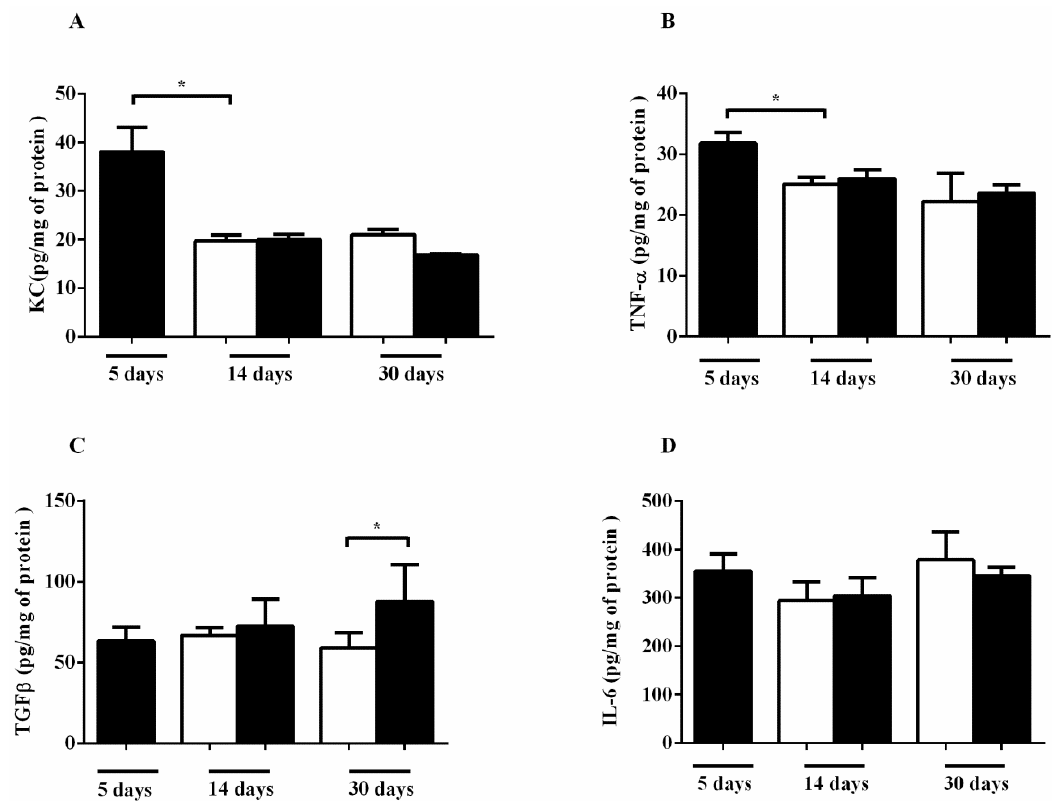
Figure 4. Effects of CS on cytokine production in the lung. The mice were exposed to 5, 14 and 30 days of CS (black bars) or ambient air (white bars) for 14 and 30 days and lung homogenates were isolated. The cytokines were measured by ELISA for ( A ) keratinocyte chemoattractant (KC), ( B ) interleukin-6 (IL-6), ( C ) tumor necrosis factor- α (TNF- α ) and ( D ) transforming growth factor- β (TGF- β ). Data represent the means ± SEM of 7–10 mice per group. * p < 0.05 compared to control. All statistical analyses were performed with a one-way ANOVA, followed by a Tukey’s post hoc test.